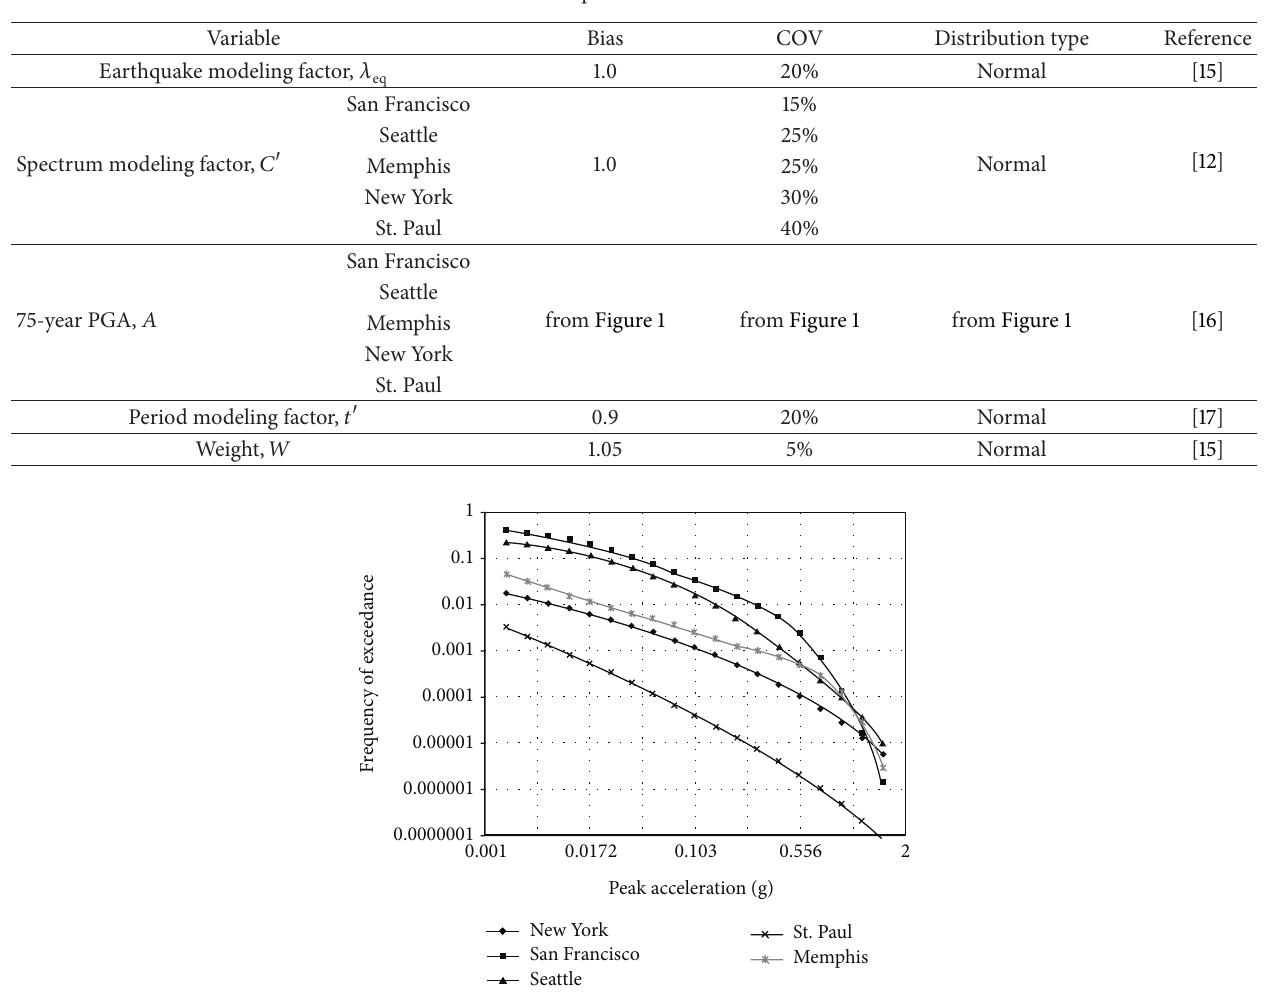
Table 3: Earthquake load related statistics.